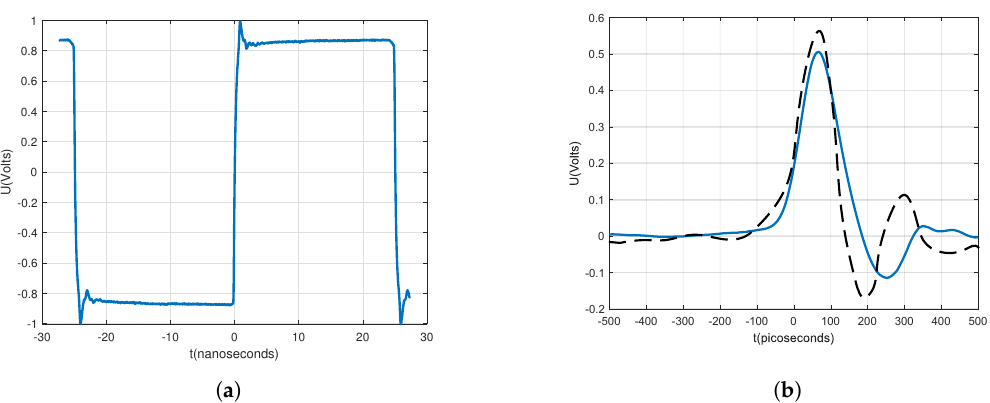
Figure 4. Input and output generator signals, measured with a high sampling rate oscilloscope. ( a ) Clock signal on generator input. ( b ) Generated pulse (blue line) at output in comparison with the pulse (dashed black line) from